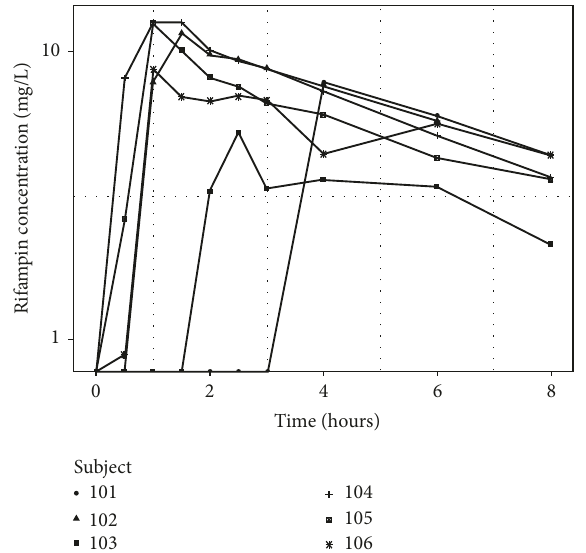
Figure 3: Individual plots of serum rifampin concentration-versus- time